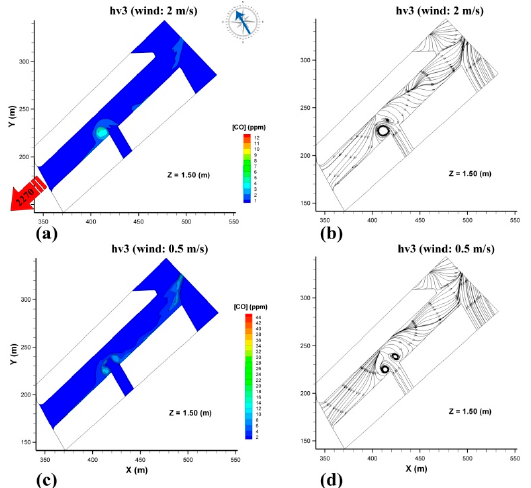
Figure 11. CO concentration contours (ppm) and streamlines in the hypothetical case hv3 for 2 m/s in ( a , b ) and for 0.5 m/s in ( c , d ). Traffic and wind direction are marked with red and blue arrows, respectively.